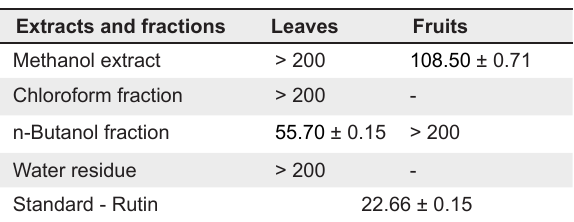
Table 1. Results of the DPPH radical scavenging activity,